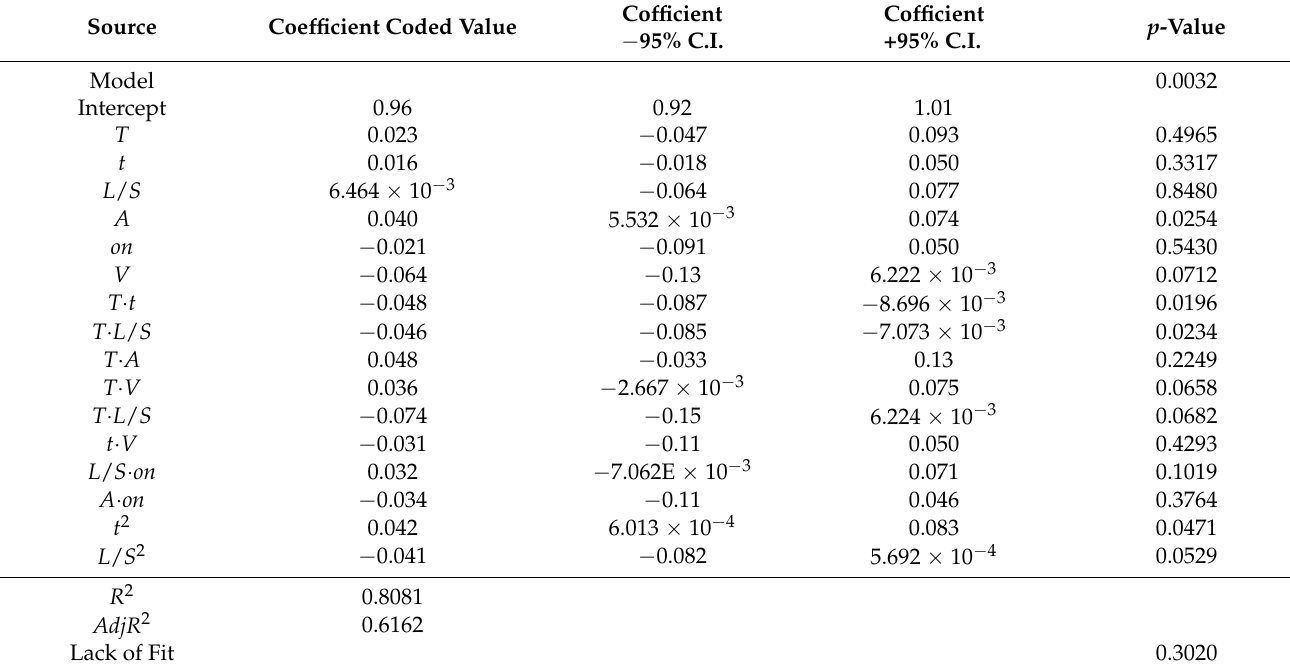
Table 2. Model for total carotenoid yield ( TC ) as a function of input variables and analysis of variance.